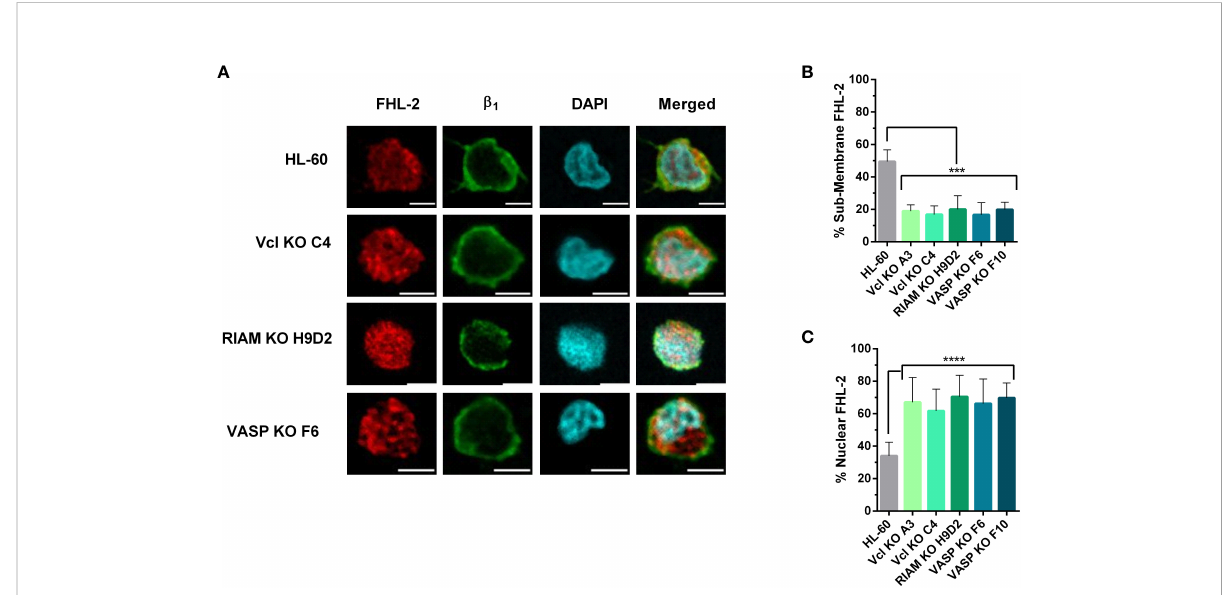
FIGURE 5 FHL-2 nuclear translocation is enhanced in Vinculin, RIAM and VASP knockouts. (A) HL-60 parental cells and the knockouts for Vcl, RIAM, VASP HL-60 cells were differentiated into neutrophilic-like cells with 1 m M all- trans retinoic acid for 48 h, fi xed, permeabilized and fl uorescently labelled using anti-FHL-2 and anti- b 1 integrin antibodies and DAPI. Confocal microscopy images were analyzed using the ImageJ software package and are representative results from 3 independent experiments. Bars indicate 5 µm. (B, C) Subcellular distribution of FHL-2. The graphs represent the quanti fi cation of images. Results are represented as relative to the wild-type nuclear ratio and are from 3 independent experiments with at least 50 cells. Data are presented as mean ± SD, where the error bars denote standard deviation. Signi fi cance (ANOVA) has been calculated with respect to HL-60 controls, ***denotes p<0.005, and ****,